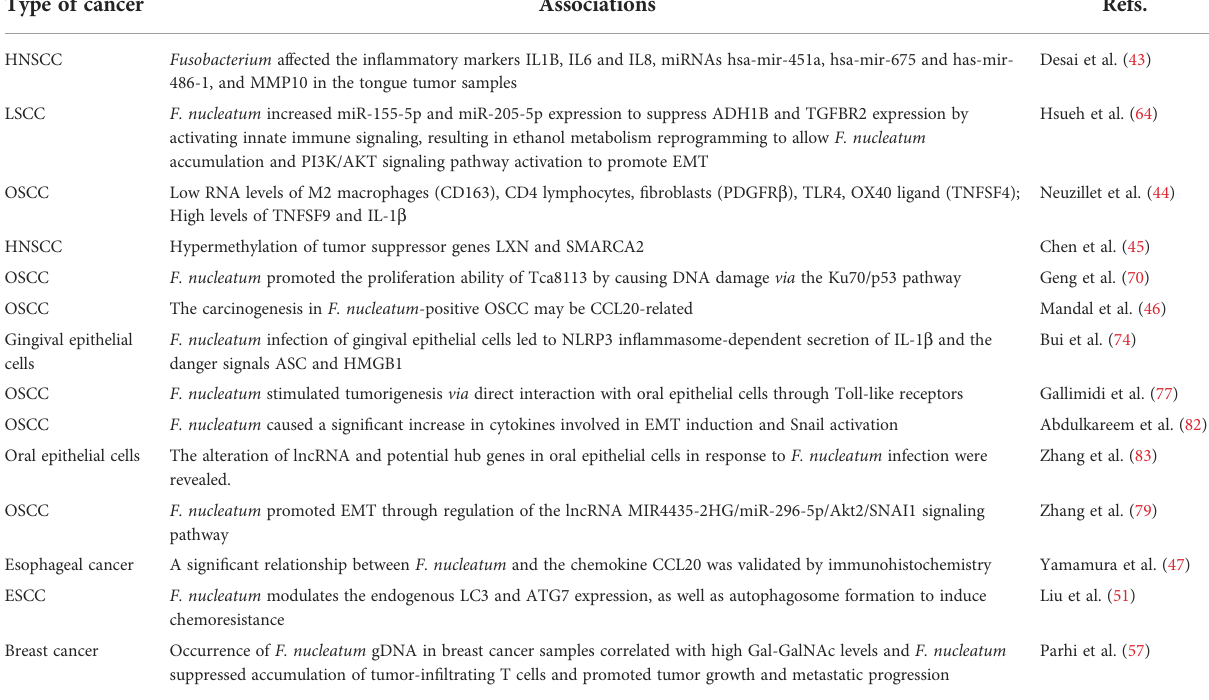
TABLE 3 Reported genes involved in F. nucleatum -associated malignancies except for colorectal cancer. Type of cancer